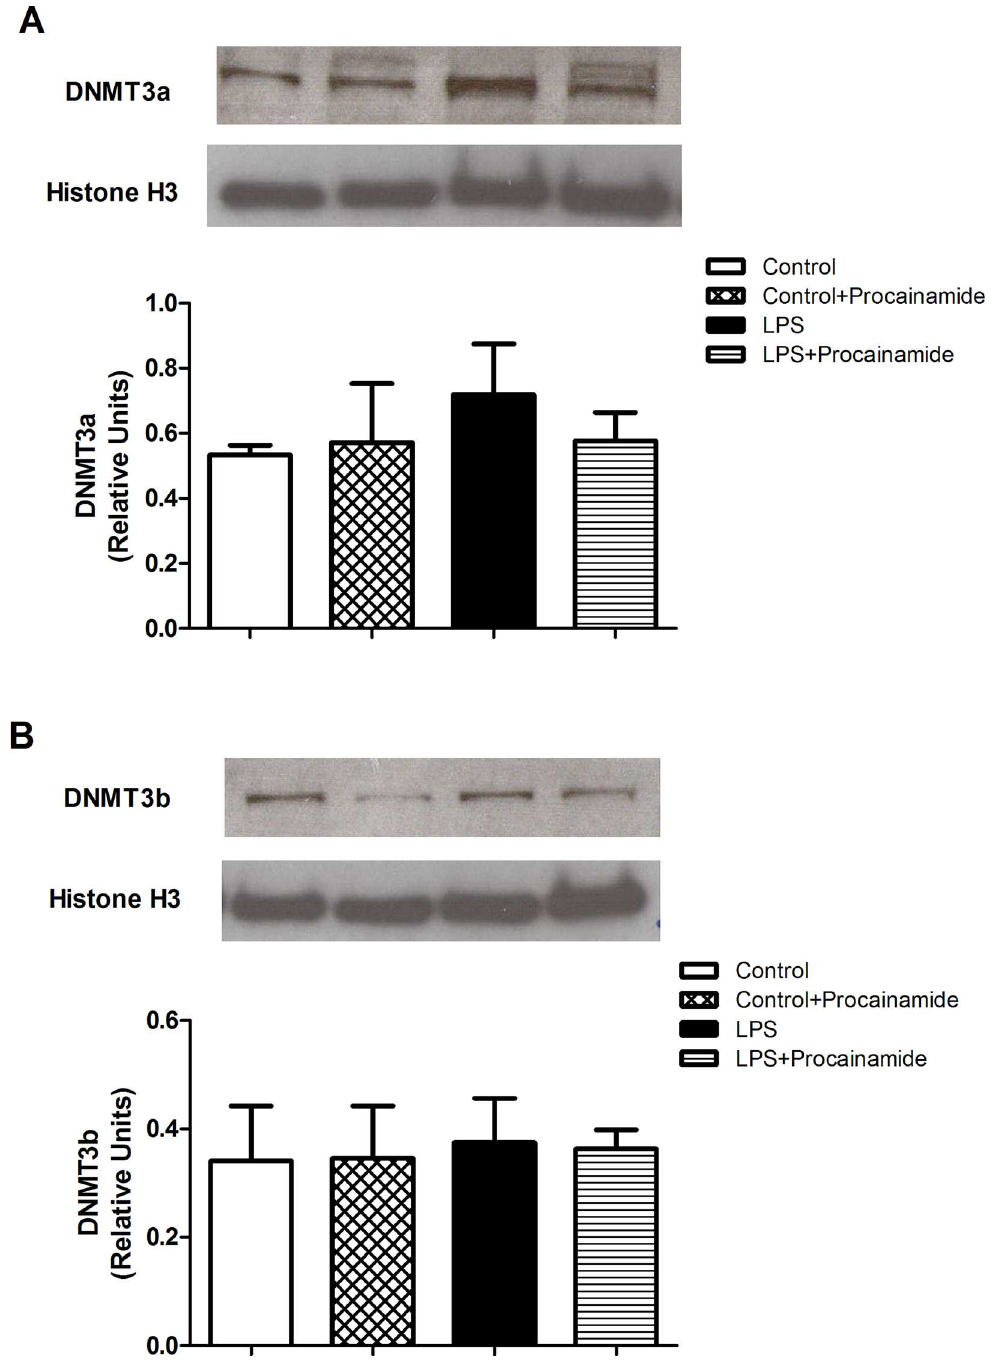
Fig 9. Effects of procainamide on the expressions of (A) DNMT3a and (B) DNMT3b in the lungs obtained from different groups of animals. Depicted are changes in lung DNMT3a and DNMT3b expressions at the end of experiment(at 6 h) in different groups of rats that received salineat time 0 (Control, n = 3), received saline as in Control group and then received procainamide at 1 h (Control + Procainamide, n = 3), received LPS at time 0 (LPS, n = 3), and received LPS at time 0 and then received procainamide at 1 h (LPS + Procainamide, n = 3). Data are expressed as mean ± SEM. * P < 0.05, all versus Control rats; # P < 0.05, with versus without procainamide in LPS